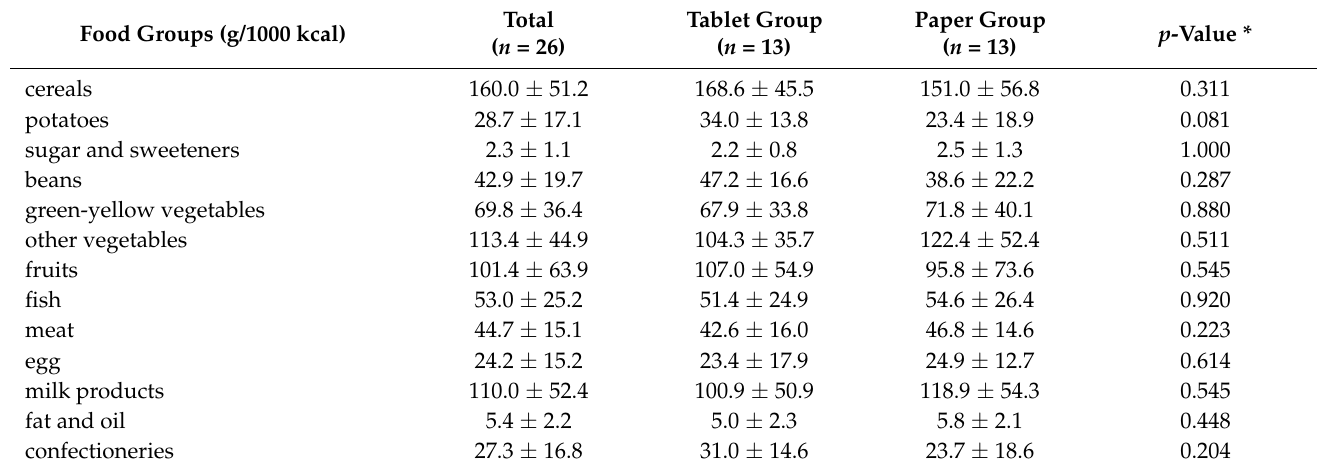
Table 4. Adjusted geometric means of daily food group by tablet-based and paper-based groups at the baseline.